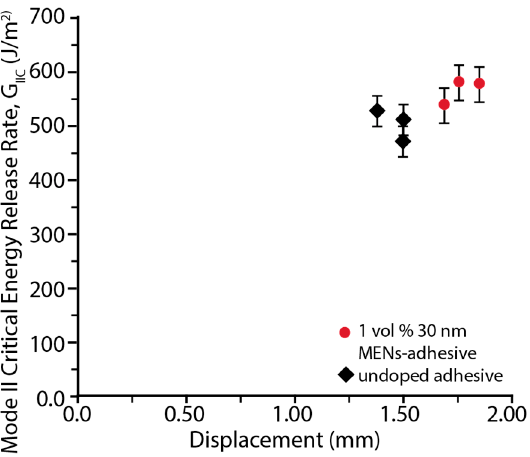
Figure 7. G IIC of undoped and doped adhesives with 1 vol%